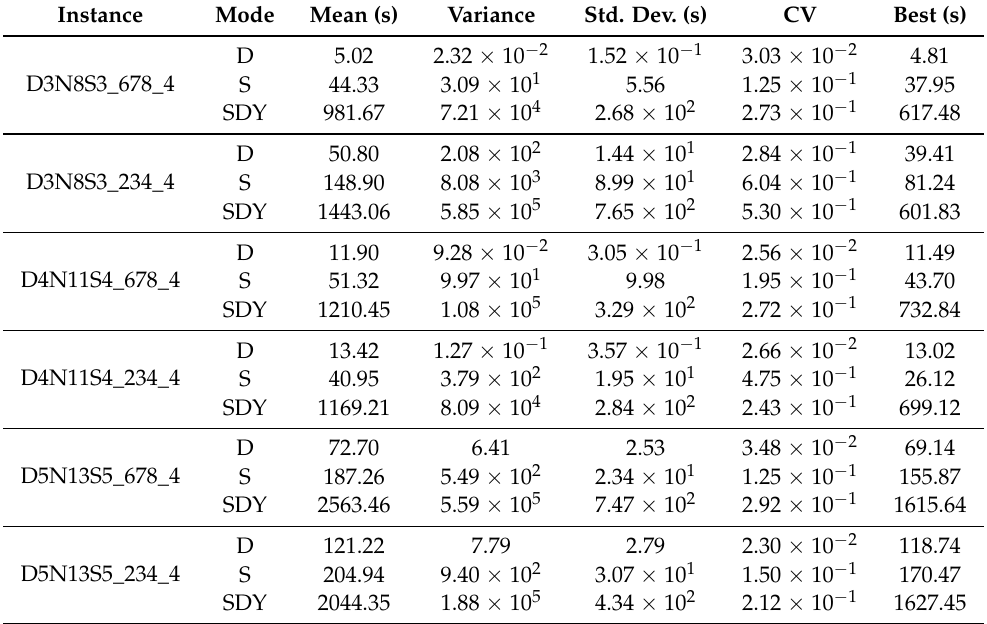
Table 13. Results of Computation Time with (Maximum) 4 Vehicles.